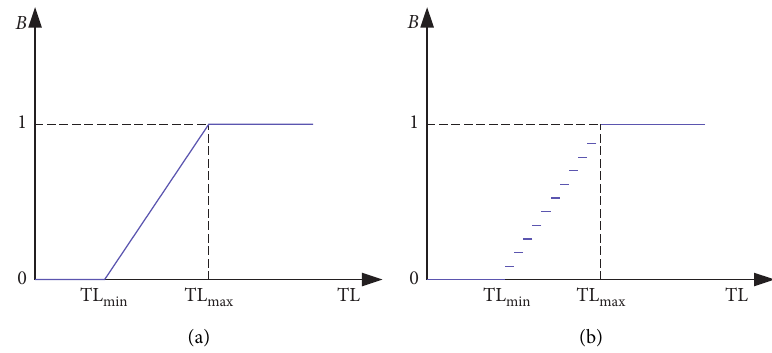
Figure 6: Examples of color mapping. (a) Linear mapping. (b) Scaled mapping.